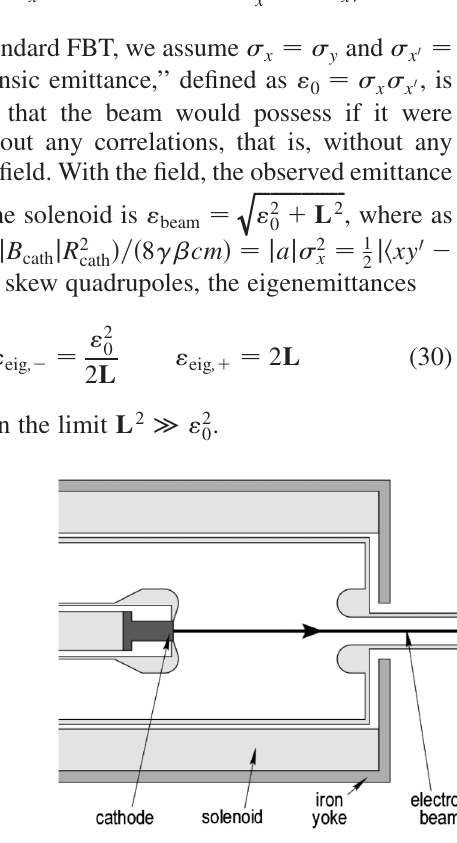
FIG. 3. Conventional x - y FBT configuration—initial beam correlations are established at the cathode with an applied axial magnetic field, altering the beam’s eigenemittances, and these new eigenemittances are recovered through three skew